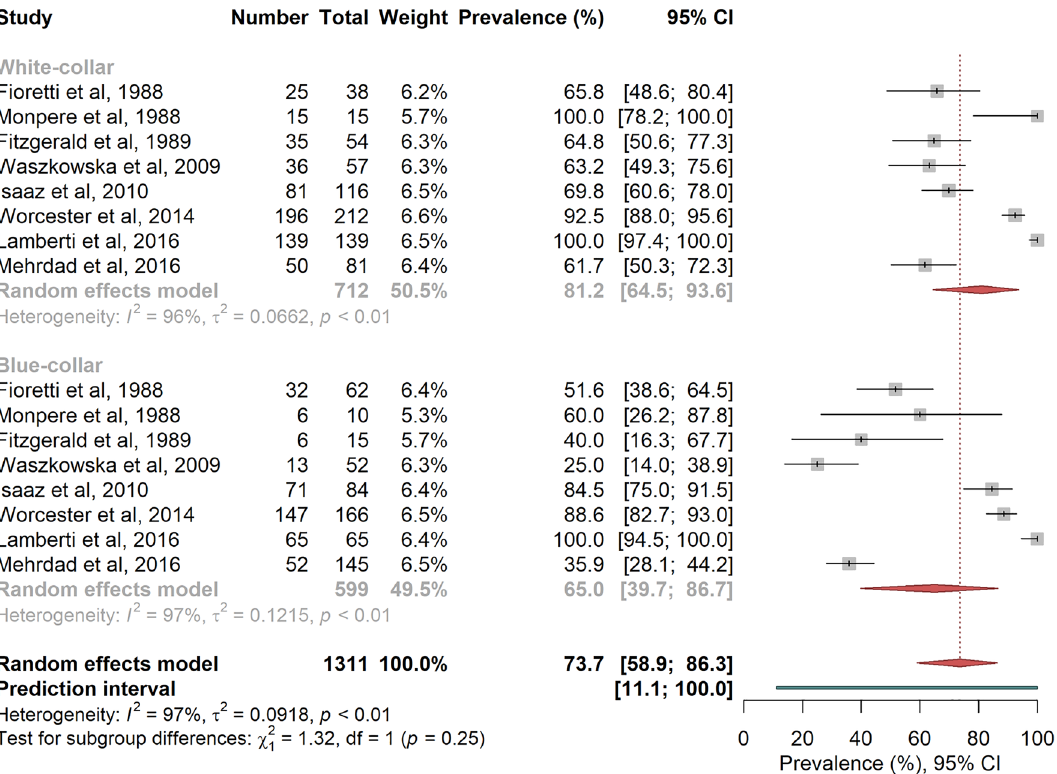
Figure 4. Random-effects meta-analysis of return-to-work prevalence according to socio-professional category. The squares and horizontal lines correspond to the study-specific prevalence and 95% CIs. Proportionally sized boxes represent the weight of each study. The diamond represents the pooled prevalence and 95% CI of the overall population. The horizontal thick line corresponds to the 95% prediction